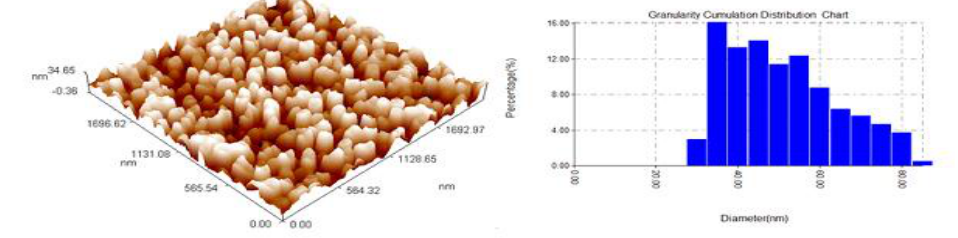
Fig.(d): AFM images for nanostructure at energy 500 mJ with (Avg. Diameter: 80 Fig.2: Topographical images of PbS nanostructure at different laser energies.